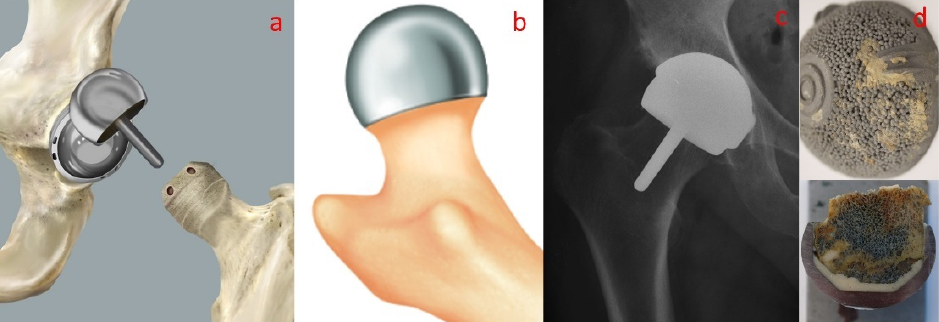
Figure 4. Aspects regarding the handling of bone cements for resurfacing hip prosthesis (e.g., BHR) fixation: ( a ) bone preparation; ( b ) cement pressure into the prosthetic components; ( c ) postoperative radiography; ( d ) failed BHR hip prostheses [63].